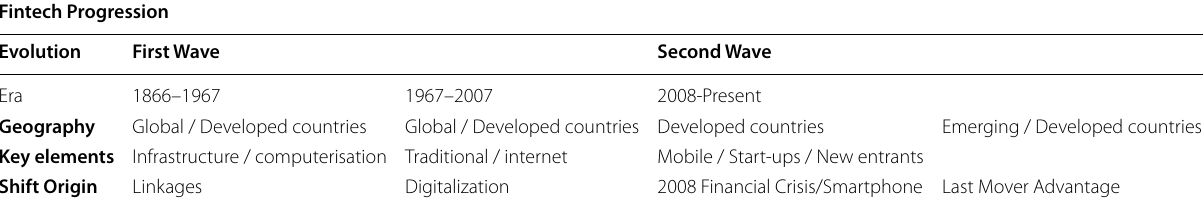
Key elements Infrastructure / computerisation Traditional /